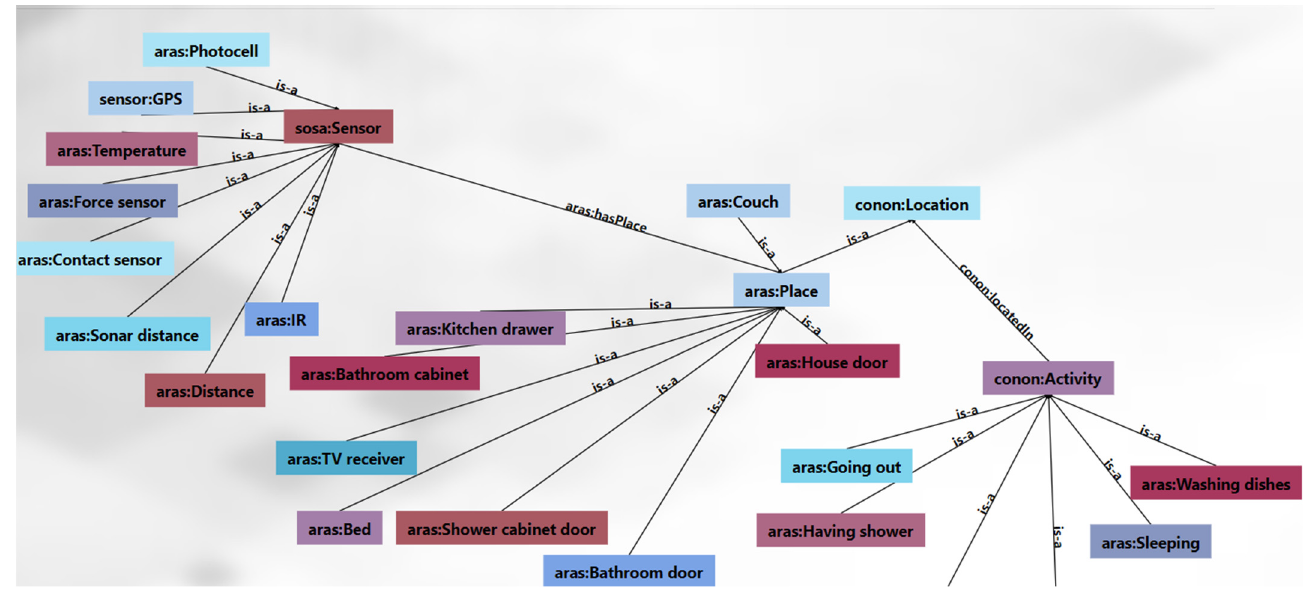
Figure 23. Ontology-based model evolution at t 2 in the merging phase, an excerpt of the evolved ontology-based model at t 2 .